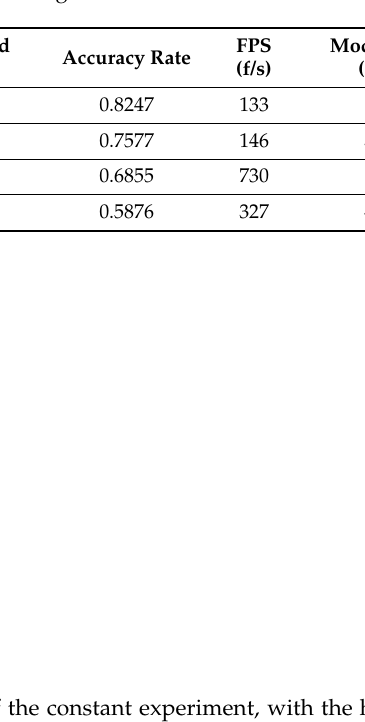
FCN ‐ 32s use the convolutional part of vgg16 as the backbone and change the last three fully connected layers of vgg16 to convolutional layers as well. Table 2. The table shows the results of the constant experiment, where threshold x indicates the different OKS thresholds, the corresponding value is the proportion of the number of test samples satisfying the threshold to the total number of test samples, and accuracy rate indicates the ratio of the number of test samples with the distance between the predicted coordinates and the real coordinates to the number of test samples with the radius of the inner tangent circle of the target ground truth less than 1. FPS indicates the number of images that our experimental platform can process per second, and model size indicates the size of the trained model weights.